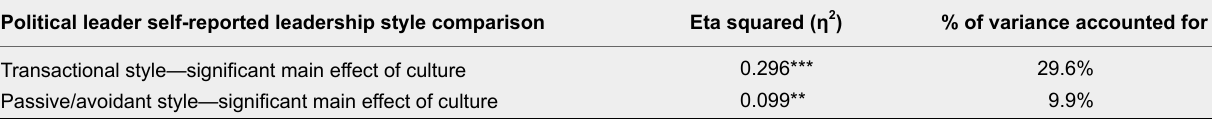
Effect Sizes Associated With Significant Main Effects After Analysis of Covariance Political leader self-reported leadership style comparison Eta squared (η 2 ) % of variance accounted for Transactional style—significant main effect of culture Passive/avoidant style—significant main effect of